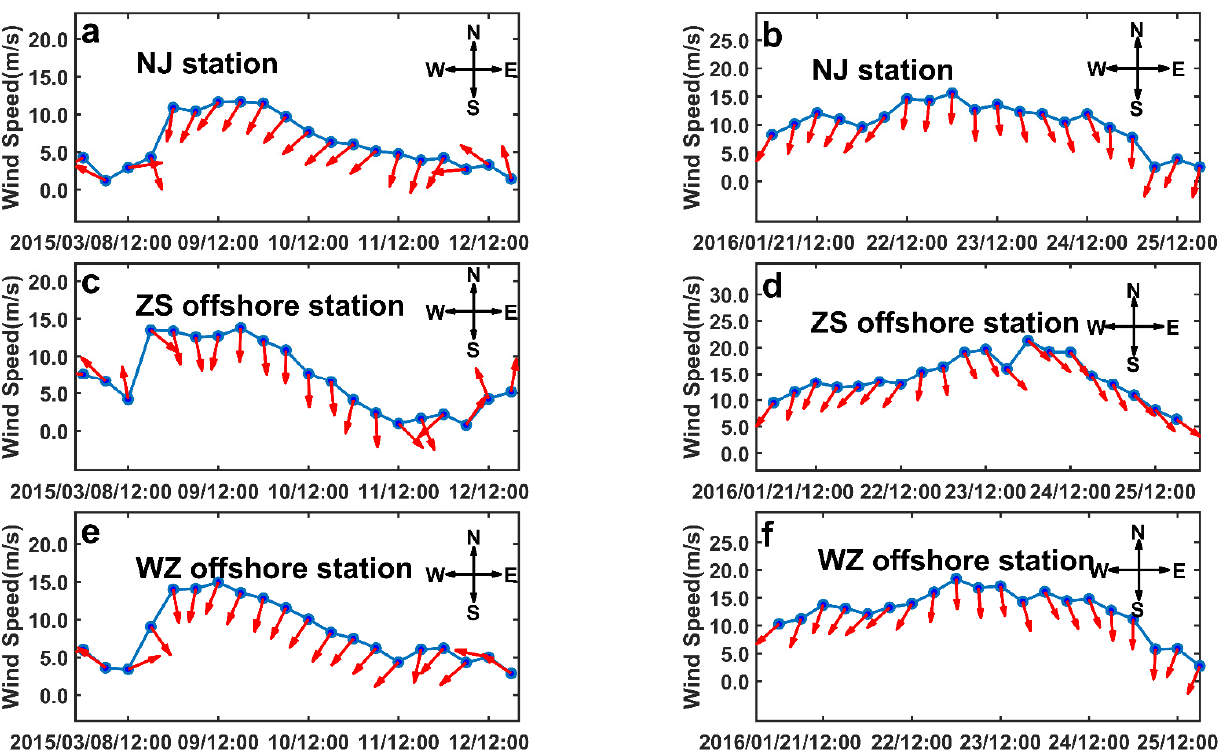
Figure 6. CCMP wind speed and direction at ( a ) NJ station from 8 to 12 March 2015, ( b ) NJ station from 21 to 25 January 2016, ( c ) ZS offshore station from 8 to 12 March 2015, ( d ) ZS offshore station from 21 to 25 January 2016, ( e ) WZ offshore station from 8 to 12 March 2015, and ( f ) WZ offshore station from 21 to 25 January 2016.